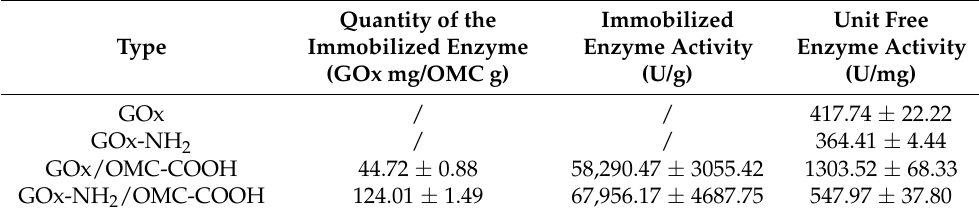
Table 1. Enzyme activity of free enzyme or enzyme immobilized in COOH-OMC.